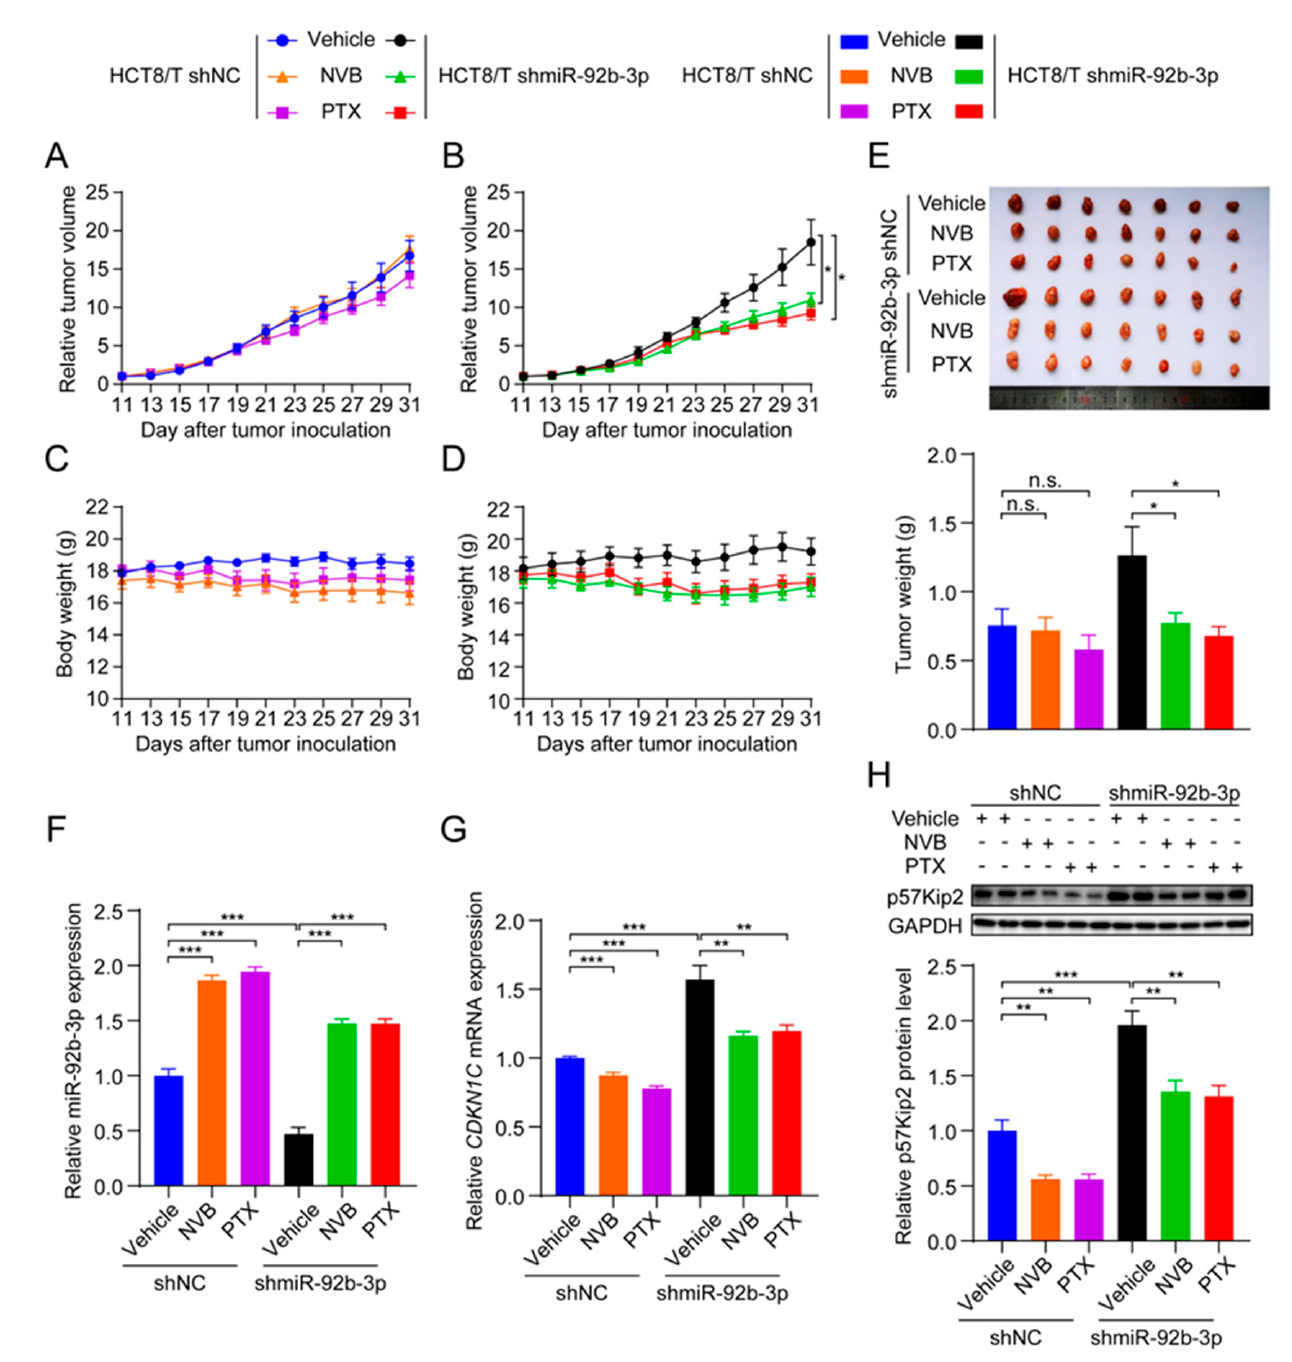
Figure 7. miR-92b-3p suppresses the sensitivity of HCT8/T xenograft tumors to chemotherapeutic drugs. Nude mice bearing CRC xenografts with HCT8/T control and miR-92b-3p knockdown cells were administered NVB (4 mg/kg) or PTX (20 mg/kg) by intraperitoneal injection every three days for 21 days and vehicle group mice received equal volume solvent. Tumor volume and body weight were recorded every two days. ( A – D ) The change in relative tumor volume and body weight over time. ( E ) The image and weight of the xenograft tumors at the end of treatments. ( F ) Relative miR-92b-3p expression levels in xenograft tumors evaluated by qRT-PCR. ( G , H ) The CDKN1C expression levels in xenograft tumors by qRT-PCR and western blotting analysis. Detailed information about Western Blot can be found at Supplementary Materials. n.s. p > 0.05; * p < 0.05; ** p < 0.01; *** p < 0.001.